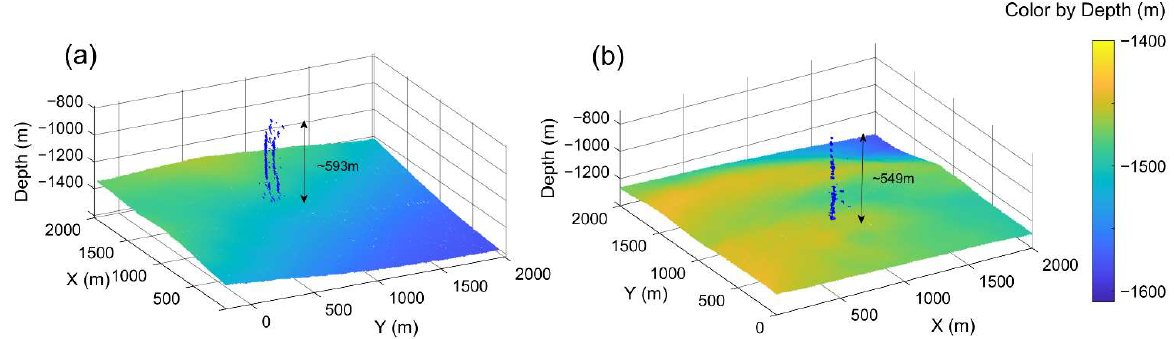
Figure 15. Two plumes extracted by this method. ( a ) is the extracted plume in experimental area 2; ( b ) is the identified and extracted single plume in experimental area 1.